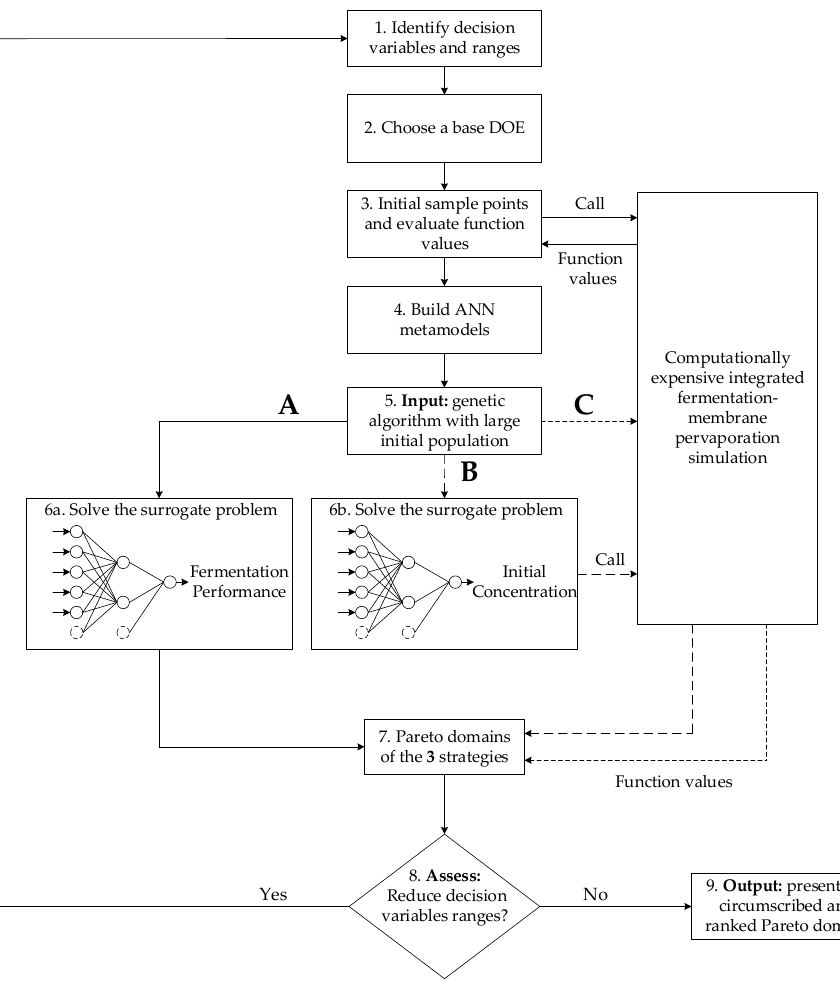
Figure 4. Multiobjective optimization and analysis of the integrated fermentation–membrane pervaporation system flowchart: (A) ANN metamodels of the four objective functions; (B) process simulator with ANN metamodels providing the eight initial species concentrations; and (C) process simulator with arbitrary initial concentrations.